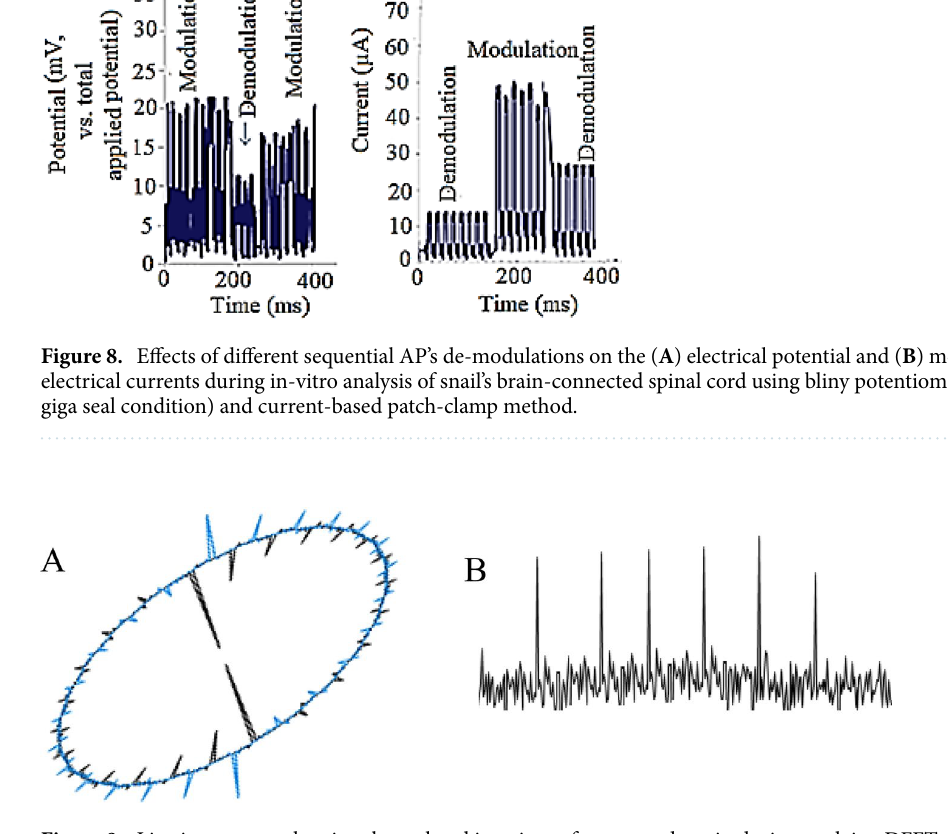
Figure 9. Lissajous curves showing the real and imaginary frequency domain during applying DFFT algorithm on the current–time domain of snail’s spinal cord ( A ) before and ( B ) after applying the de-modulation potential by blind voltage/current